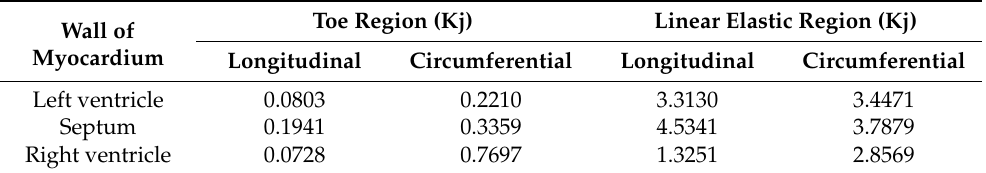
Table 3. Stored strain energy values calculated within the toe region and linear elastic region for each heart wall